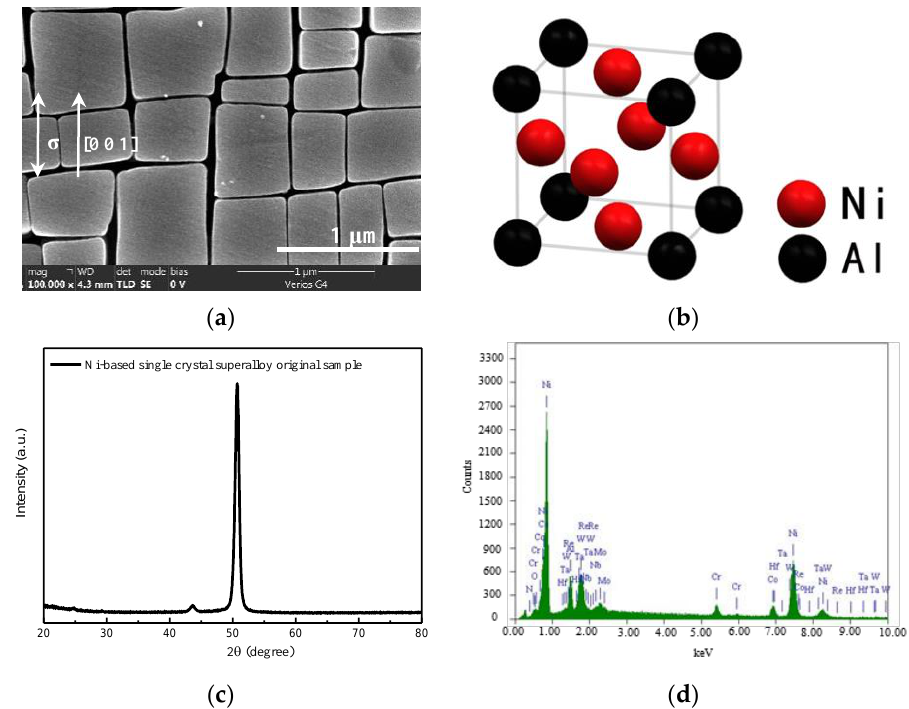
Figure 1. Nickel-based single crystal superalloy original sample. ( a ) microstructure, ( b ) unit cell, ( c ) XRD patterns, and ( d ) EDS composition results.